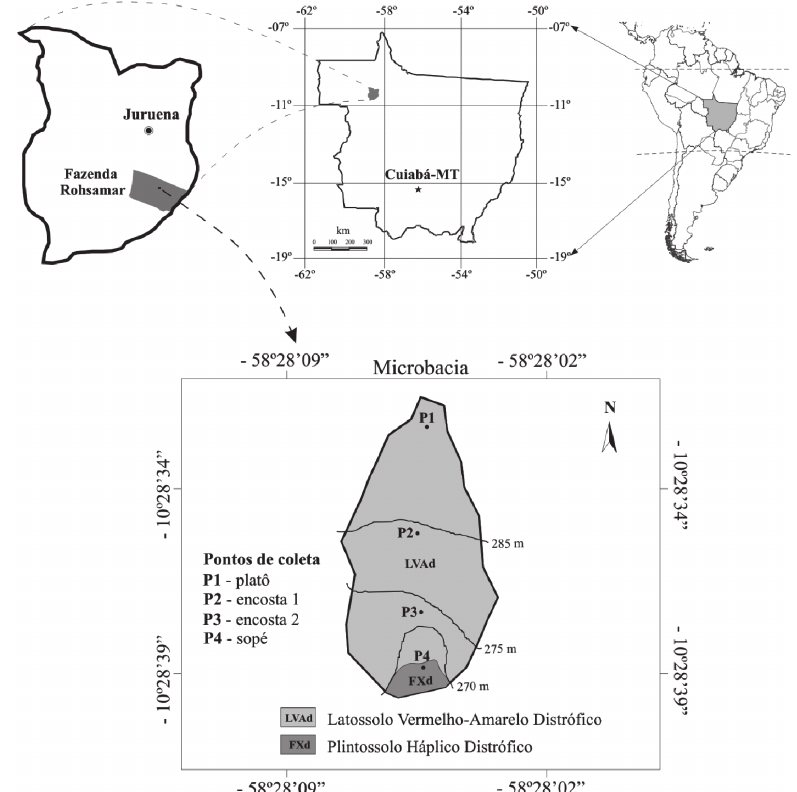
Figura 1. Localização da microbacia e distribuição dos perfis